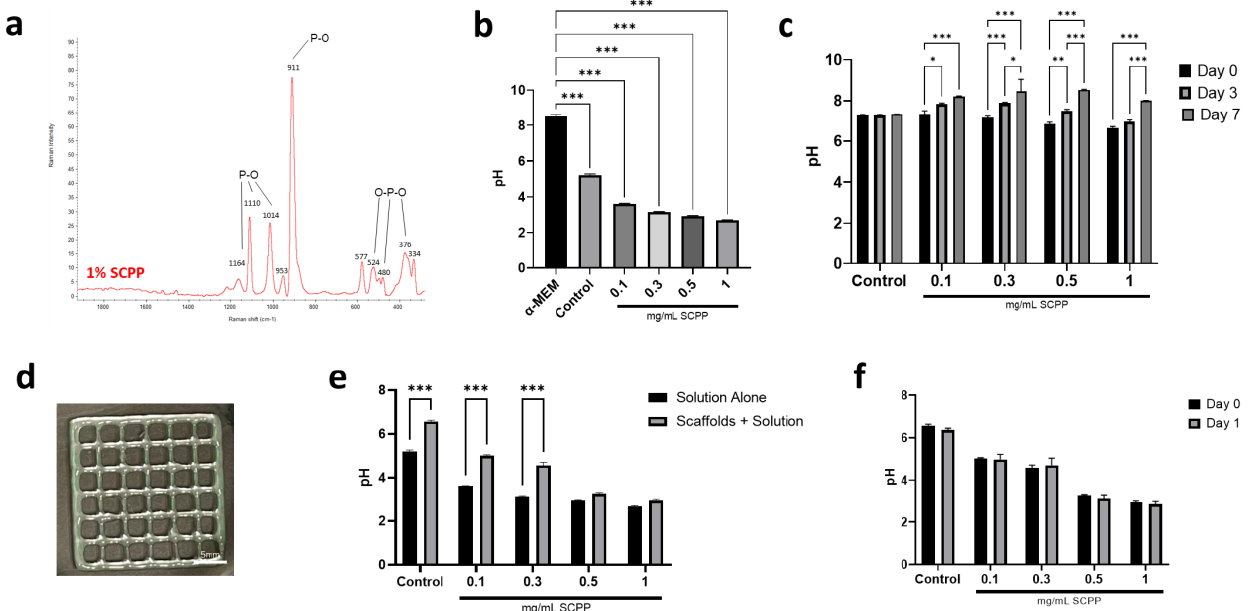
Figure 2. ( a ) Raman spectra of crystalline SCPP after synthesis. ( b ) The pH of α -MEM, CaCl 2 (con- trol), 0.1, 0.3, 0.5, and 1 mg/mL SCPP solutions immediately after SCPP synthesis and preparation. ( c ) The pH of CaCl 2 (control), 0.1, 0.3, 0.5, and 1 mg/mL SCPP mixed with α -MEM at day 0, 3, and 7. ( d ) Representative image of a 3D printed alginate/collagen scaffold. ( e ) The comparison between